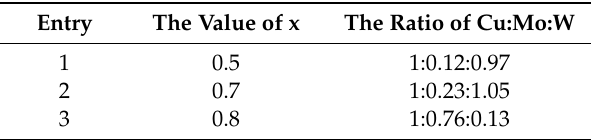
Figure 2. Energy dispersive X-ray spectra (EDX) spectra of ( a ) CuMo 0.5 W 0.5 O 4 (x = 0.5) and the plane ( A ), ( b ) CuMo 0.7 W 0.3 O 4 (x = 0.7) and the line ( B-B ), and ( c ) CuMo 0.8 W 0.2 O 4 (x = 0.8) and the plane ( C1 ). Table 1. Molar ratio of